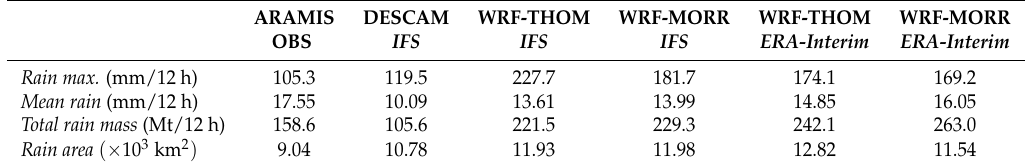
Table 3. Cumulative rain properties observed at 12:00 UTC for the ARAMIS radar network and obtained after 12 h of simulation using either the DESCAM or the WRF model. The WRF results are given for the different microphysics schemes (Thompson and Morrison) and initial data (IFS and ERA-Interim) used in this study. The maximum (in mm/12 h) and the total amount (in Megatons) of rain are obtained considering all the grid points of the innermost domain whereas the mean (in mm/12 h) and the area (in km 2 ) of rain are obtained considering only the grid points where the cumulative rain is ≥ 0.25 mm.